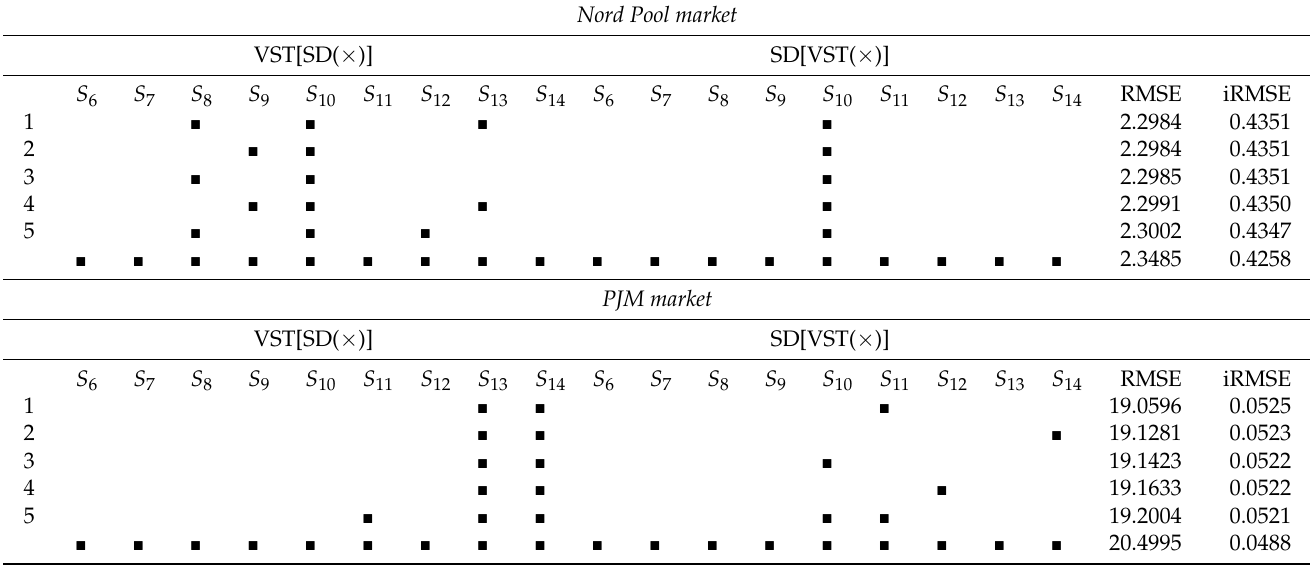
Table 2. Root mean squared errors (RMSE) and their inverse values (iRMSE) calculated in the two-year model selection window (see Figures 1 and 2) for the five best-performing combined forecasts obtained from the LEAR models with wavelet-based filtering. Squares indicate individual forecasts that are averaged in a given combination. For comparison, the last row represents averaging over all individual forecasts. Individual models where seasonal decomposition is executed first, and then the VST is applied, are labeled by VST[SD( )], whereas models with the opposite order are labeled by × SD[VST( ×